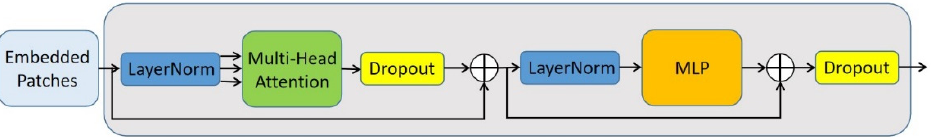
the network have low resolution. Applying transformer encoder blocks on low-resolution feature maps can reduce the expensive computational overhead and memory cost.